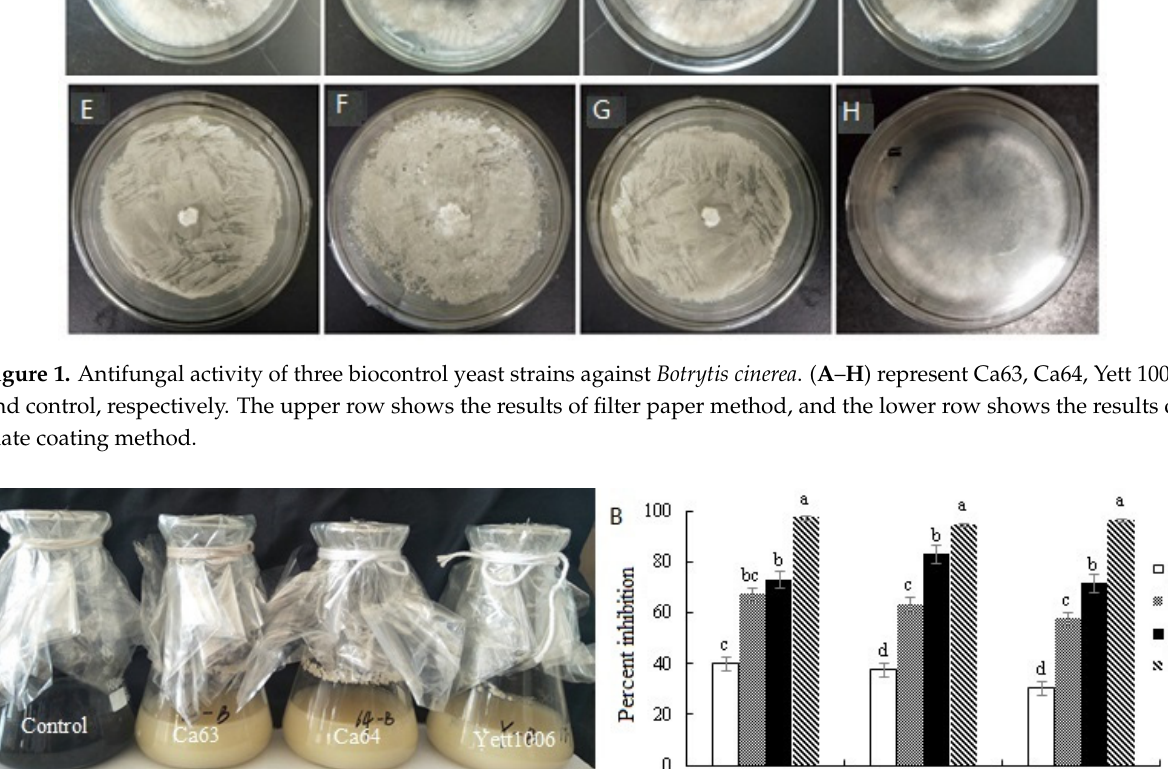
Figure 1. Antifungal activity of three biocontrol yeast strains against Botrytis cinerea . ( A – H ) represent Ca63, Ca64, Yett 1006, and control, respectively. The upper row shows the results of filter paper method, and the lower row shows the results of plate coating method.